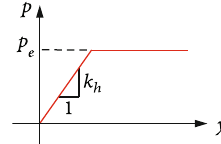
Figure 5: Bilinear elastic-plastic p - y curve.